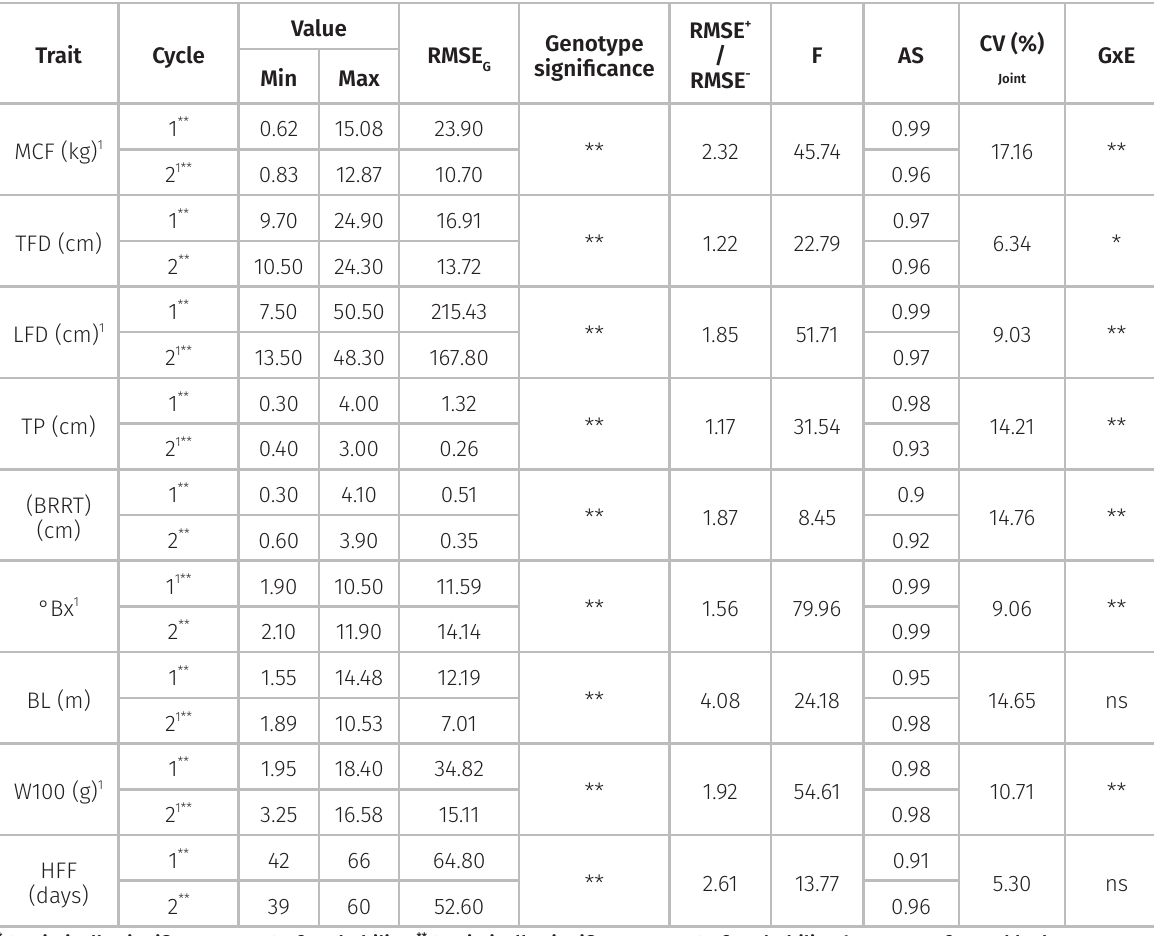
Table I. ANOVA summary for agronomic traits evaluated: Mass of characterized fruit (MCF), transverse fruit diameter (TFD), longitudinal fruit diameter of the fruit (LFD), thickness of pericarp (TP), basal region rind thickness (BRRT), soluble solids (°Bx), branch length (BL), weight of 100 seeds (W100) and number of days until the opening of the female flower at least 50% of the plants (HFF). Genotypes root mean square error (RMSE and maximum (Max) value for each variable. Ratio of maximum root mean square error by the minimum root mean square error (RMSE + / RMSE - ). Coefficient of variation (CV) of the characters on individual analysis (Ind.) and on joint analysis (Joint). F value estimated for the accessions. Accuracy selection (AS). Significance of the characters for accession on joint analysis of the experiments and significance of the genotype-environment interaction